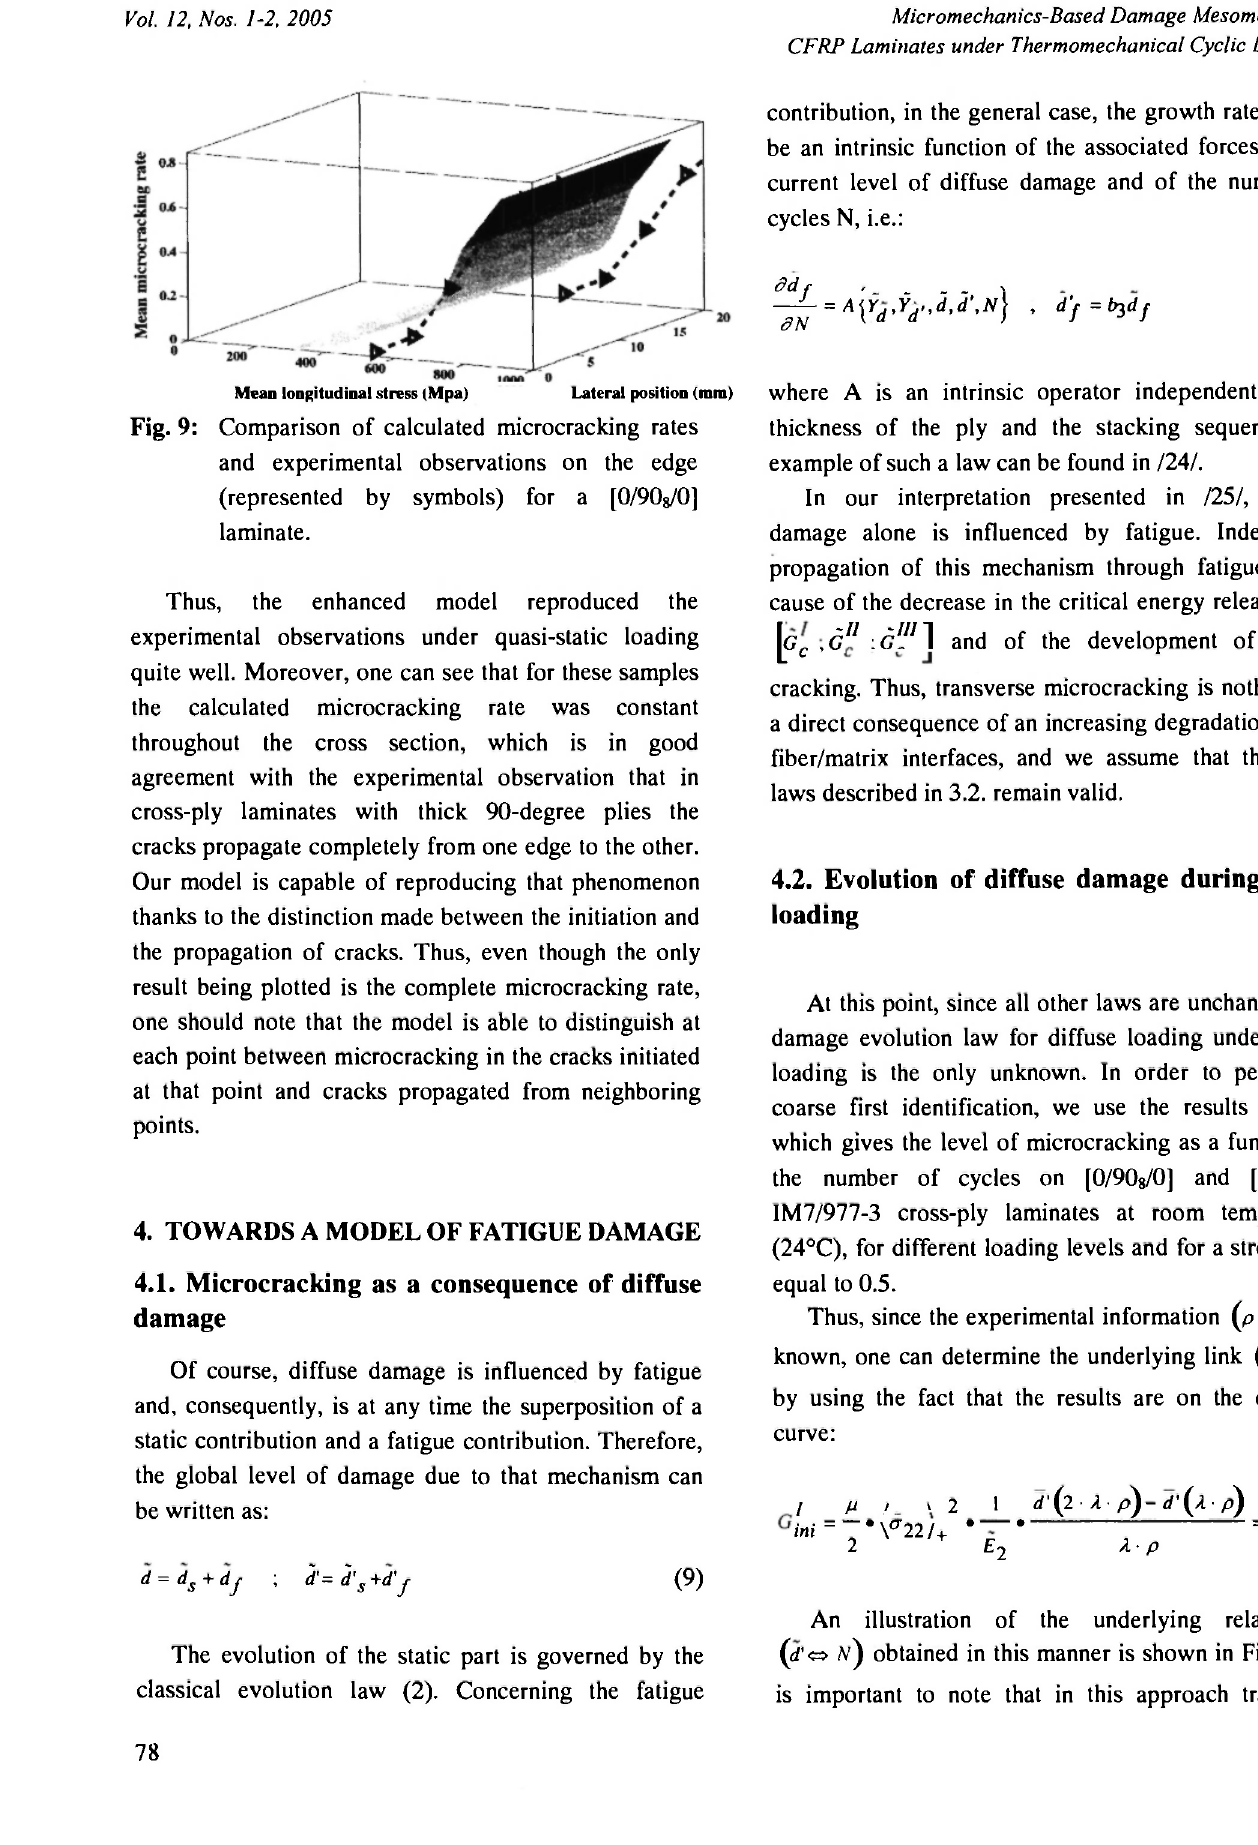
Fig. 9: Comparison of calculated microcracking rates and experimental observations on the edge (represented by symbols) for a [0/90g/0]